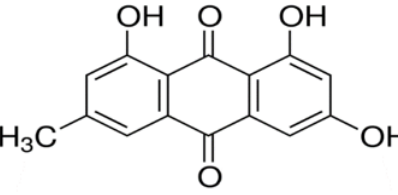
Figure 3. Structural formula of emodin.